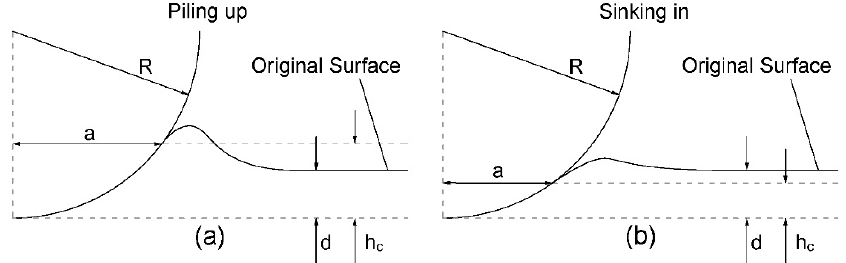
Figure 4. Schematic representation of surface morphology during spherical nanoindentation process. ( a ) “Piling up” model and ( b ) “Sinking in” model.